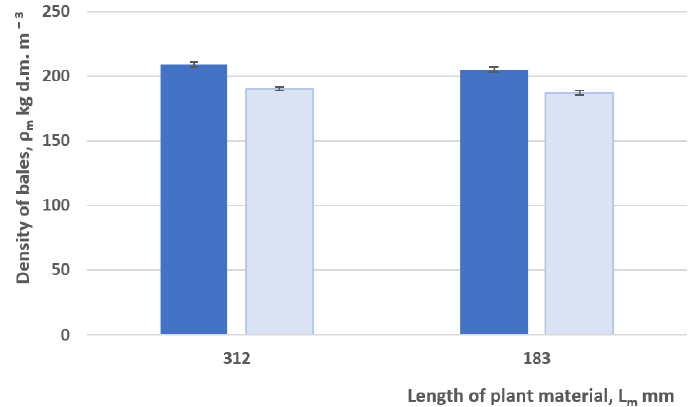
Figure 11. Bar chart of balage density in bales with additive and without additive for two plant material lengths (312 and 183 mm) at 56% moisture content and a pressing pressure of 18 MPa. d.m., dry matter.